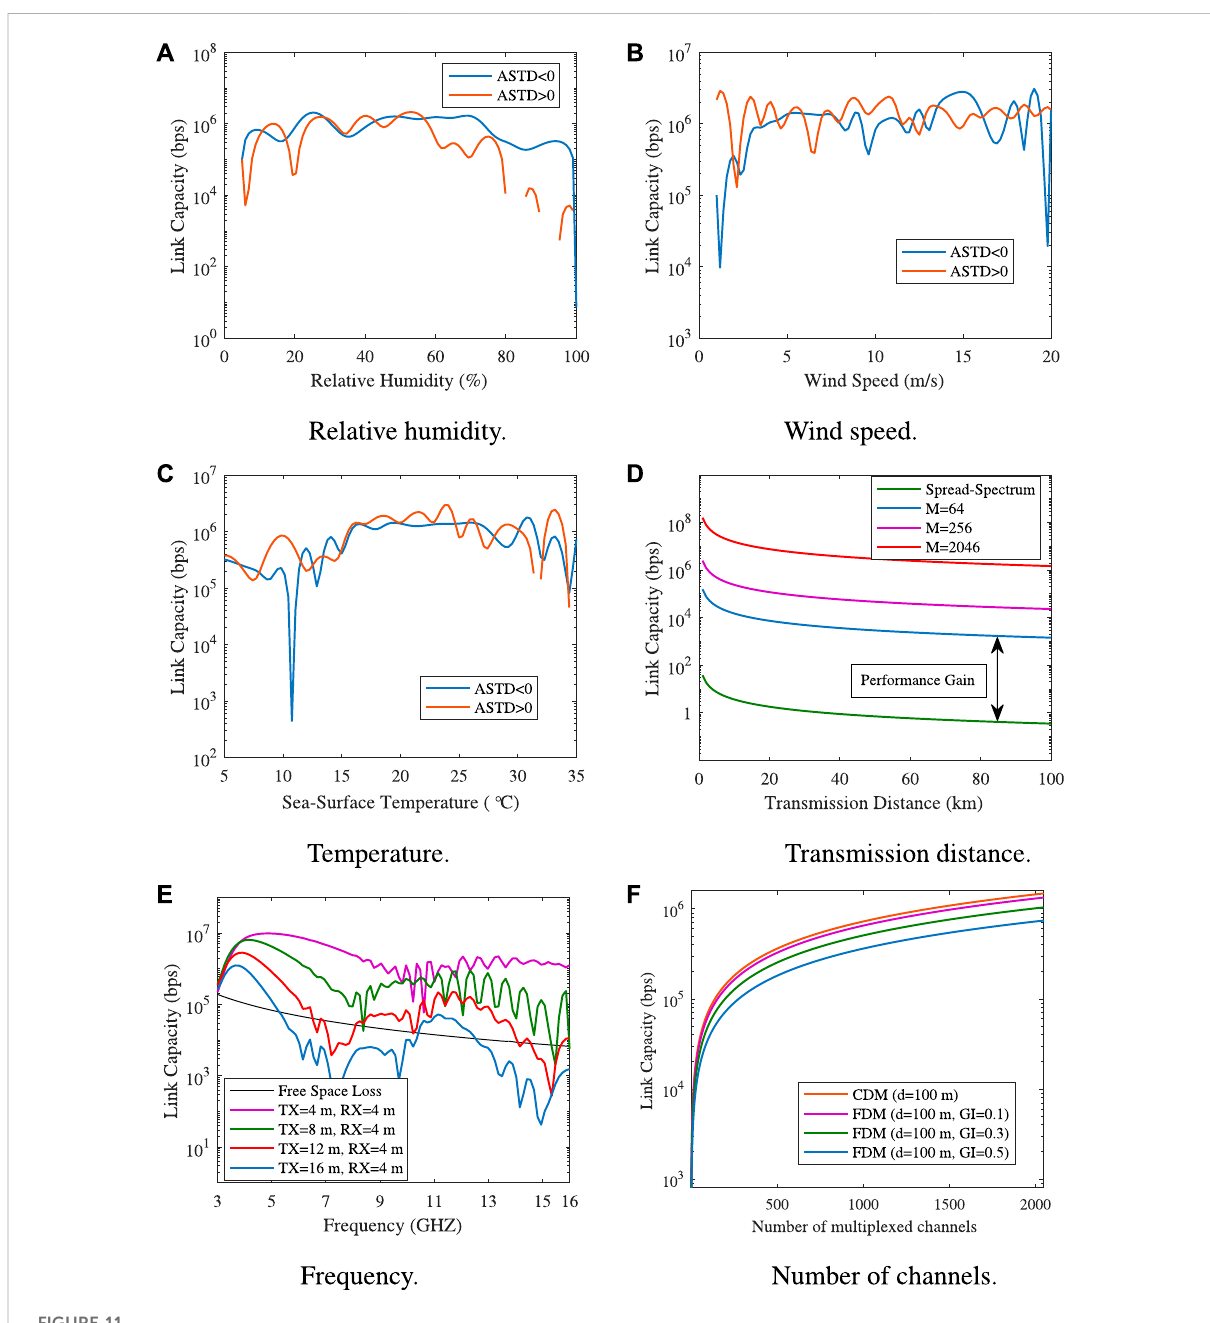
FIGURE 11 In fl uence of various factors on system link capacity. (A) Relative humidity. (B) Wind speed. (C) Temperature. (D) Transmission distance. (E) Frequency. (F) Number of channels.